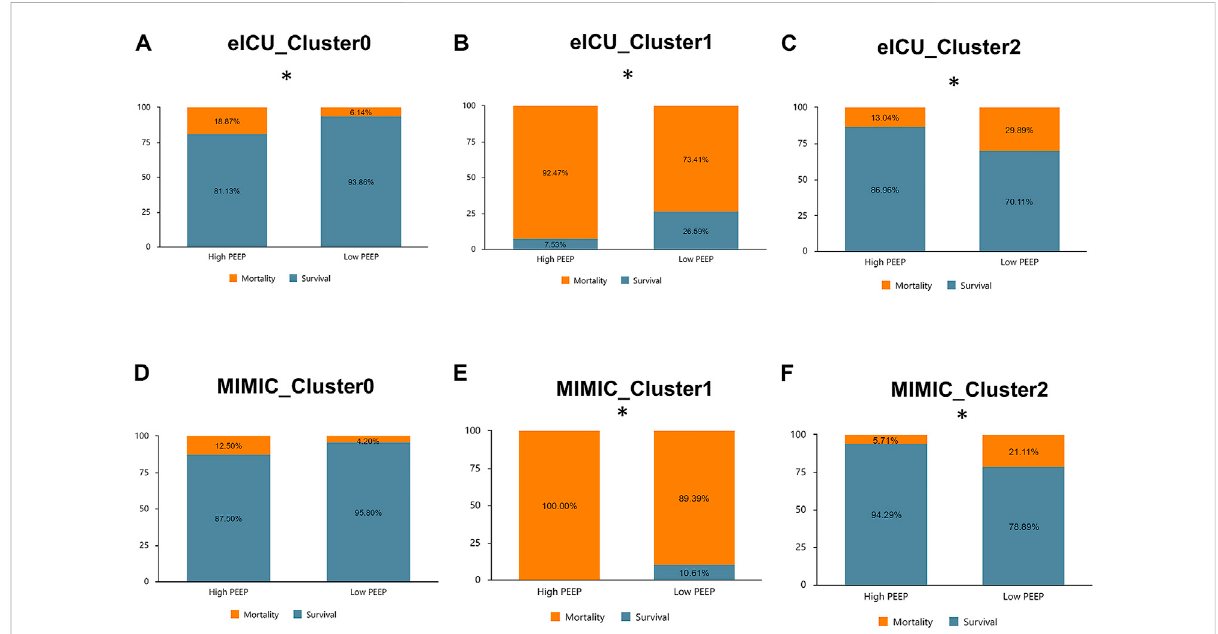
FIGURE 7 Comparison of in-hospital mortality across phenotypes at high versus low PEEP levels in the eICU derived cohort and MIMIC-IV validated cohort. (A) : Cluster 0 (eICU): high PEEP had a higher mortality rate than low PEEP (18.87% vs. 6.14%, p < 0.05). (B) : Cluster 1 (eICU): high PEEP had a highermortalityratethanlowPEEP(92.47%vs.73.41%, p < 0.05). (C) :Cluster2(eICU):highPEEPhadalowermortalityratethanlowPEEP(13.04%vs. 29.89%, p < 0.05). (D) : Cluster 0 (MIMIC-IV): high PEEP had a higher mortality rate than low PEEP (12.50% vs. 4.20%, p > 0.05). (E) : Cluster